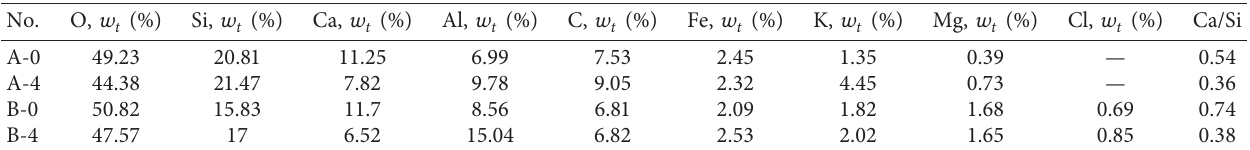
Figure 6: Microscopic morphology of soil-cement. (a) SEM image of A-0 t ( × 5000). (b) SEM image of A-4 ( × 5000). (c) SEM image of B-0 ( × 5000). (d) SEM image of B-4 ( × 5000). Table 7: Element mass ratio of C-S-H gel in EDS